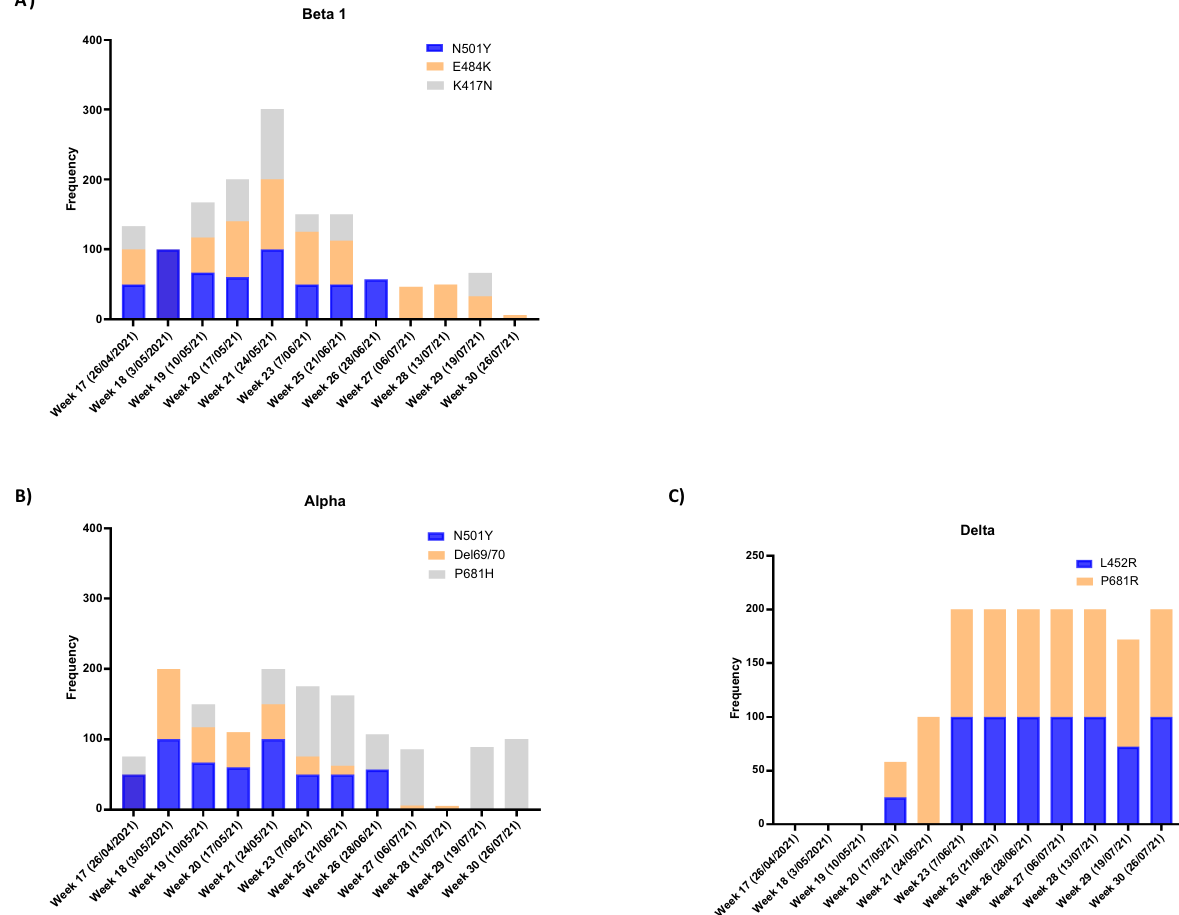
Figure 4. Temporal analysis of the City of Cape Town municipality WWTP. The frequency of the spike protein mutations during the epidemiological weeks seeks to explain patterns of the shift of key mutations linked to 3 variants of concern; ( A ) Beta, ( B ) Alpha, and ( C ) Delta variant detected over time. The mutational frequency on the y axis is represented by a stacked bar graph. Each colour represents the average mutation frequency of a variant type, which refers to the proportion of wastewater samples that were positive for a mutation divided by the total number of